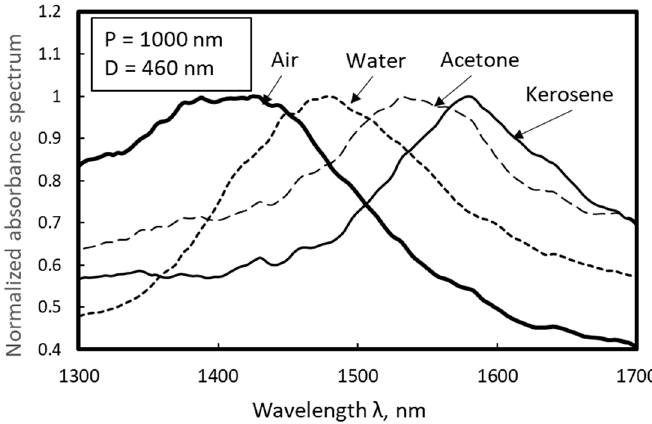
Figure 12. E ff ects of refractive index on absorbance spectra of nanodot array of 460 nm in Figure 12. Effects of refractive index on absorbance spectra of nanodot array of 460 nm in diameter.